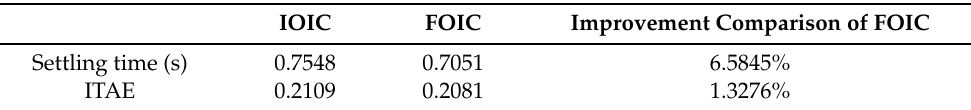
Table 9. Anti-disturbance response average performance comparison of IOIC and FOIC for ten repetitions.